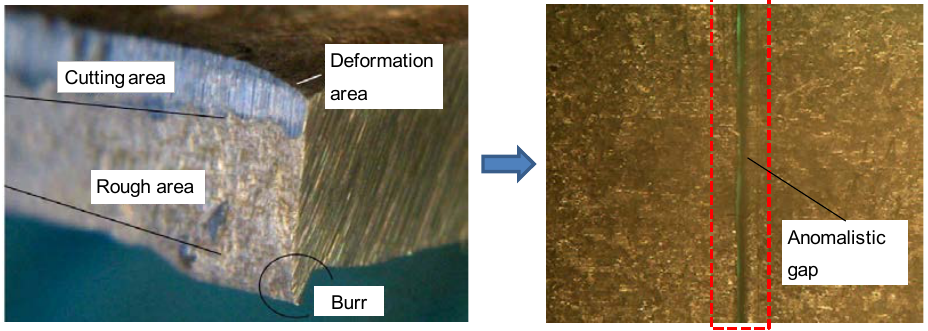
Figure 2. Illustration of a typical cross-sectional surface cut by guillotine and the anomalistic gap at the pre-welding inspection.